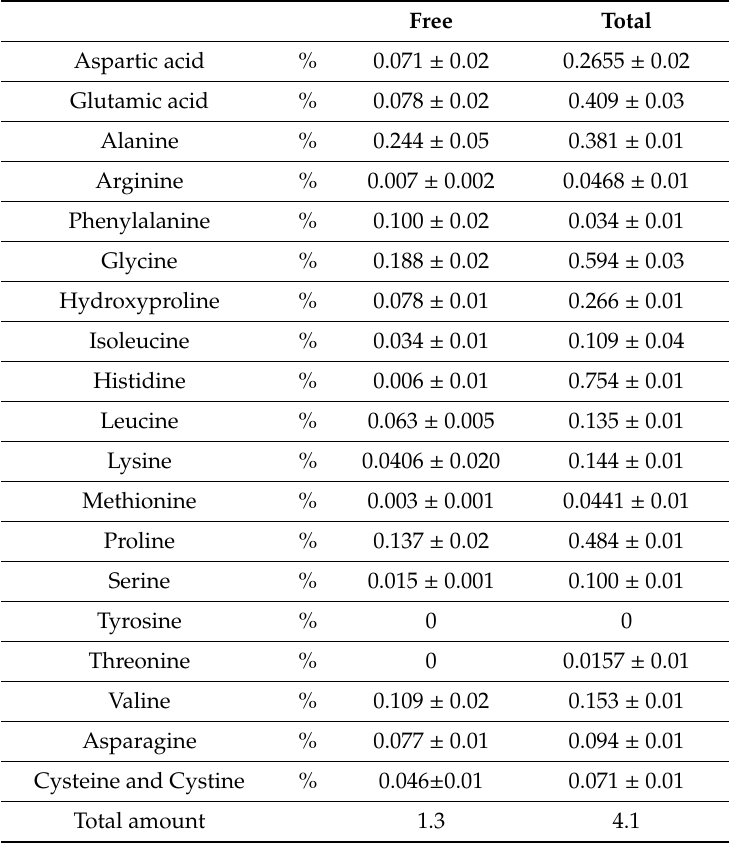
The plant extract contained 8.9 ppm of triacontanol and an amino acid profile reported in Table